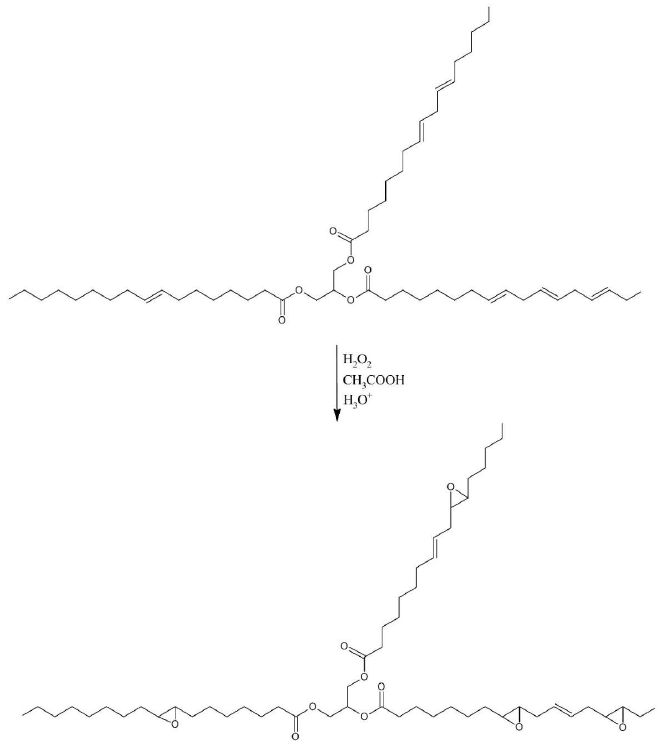
Figure 1. Schematic epoxidation reaction.